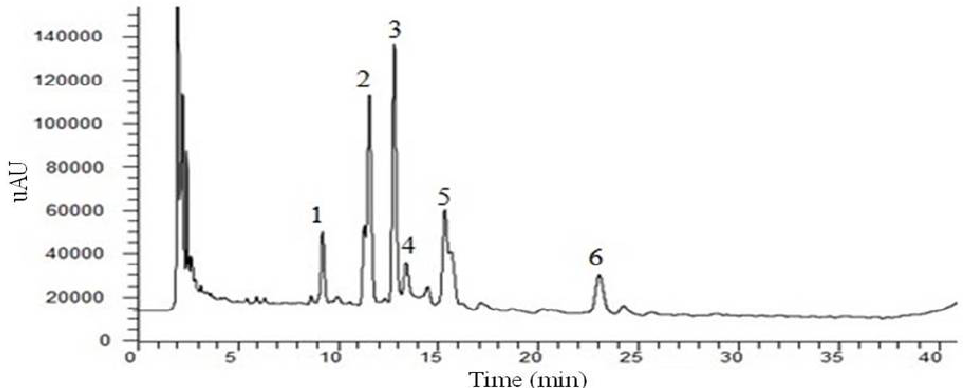
Figure 4. Chromatogram of SM-3 after elution with ethanol at 330